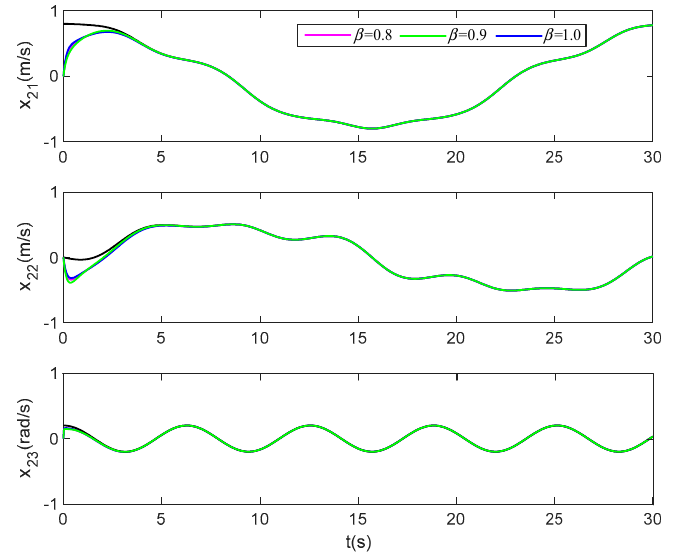
Figure 14. Velocity tracking of the vessel with different orders.